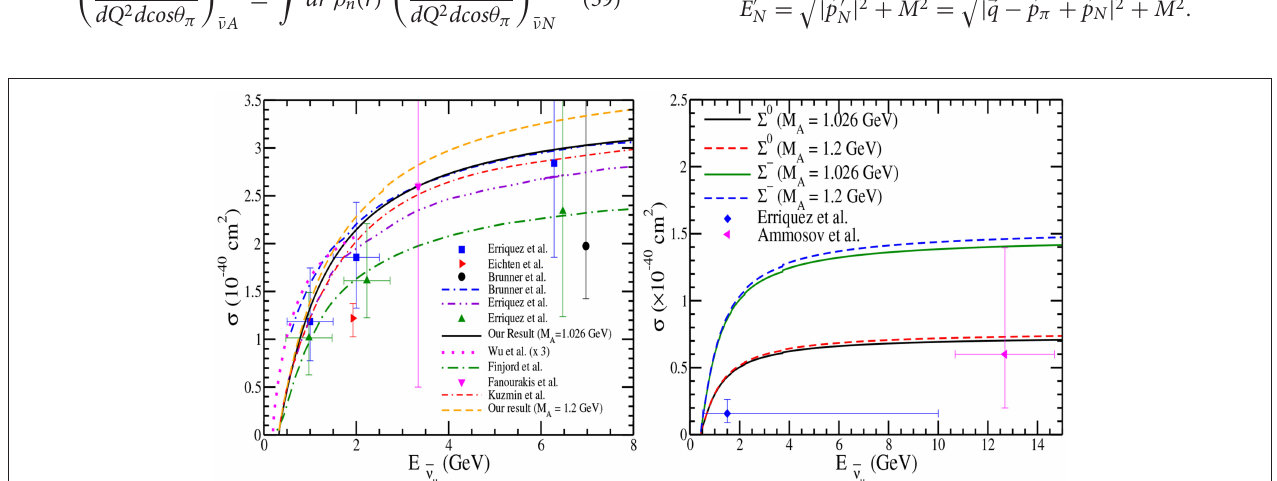
40 cm 2 ) [ 62], circle [65]) and for the 2.6 + 5.9 2.1 × 10 − = −